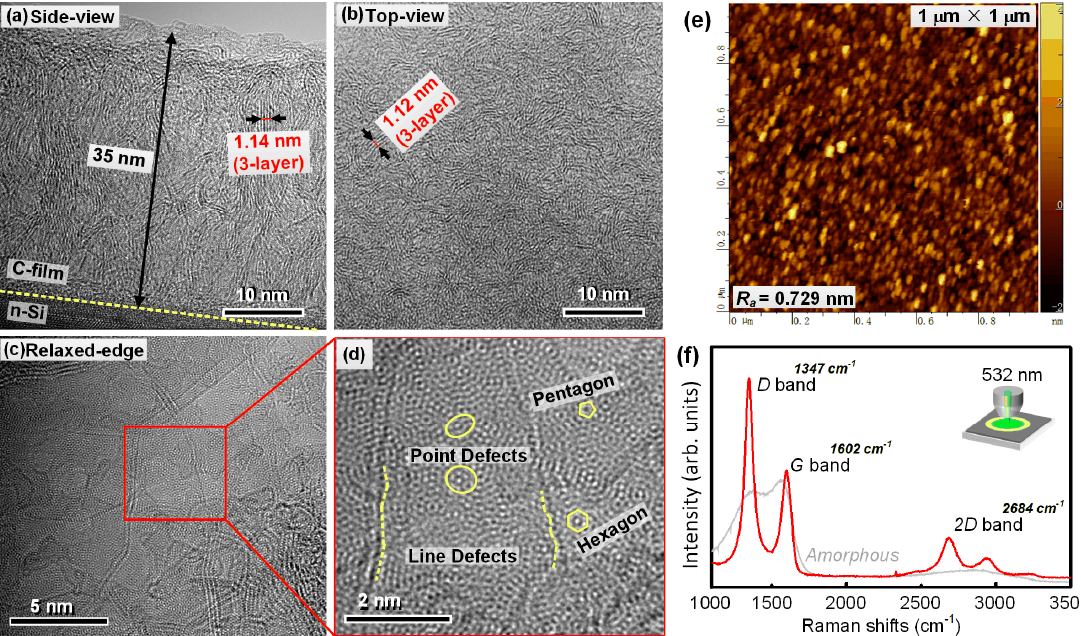
Figure 1. ( a ) Side-view TEM image of the nano-crystallited carbon film. The interface between film and substrate was indicated with yellow dash line. The distance between the atomic layers was indicated with arrows; ( b ) top-view TEM image of the nano-crystallited carbon film. The distance between the atomic layers was indicated with arrows; ( c ) high resolution TEM images at the relaxed-edge site of the film where overlapped atomic layers can be identified; ( d ) magnified image of the red-square range in ( c ). The Moir é pattern formed from honeycomb-shaped graphene lattice and point / line defects are well illuminated; ( e ) atomic force microscopy (AFM) surface morphology image of the carbon film within 1 × 1 µ m 2 area, and the Ra roughness of 0.729 nm was obtained; ( f ) Raman spectrum of the carbon film, where D , G , and 2D bands were labeled with their peak positions. The spectrum of amorphous carbon film was also exhibited in grey color for